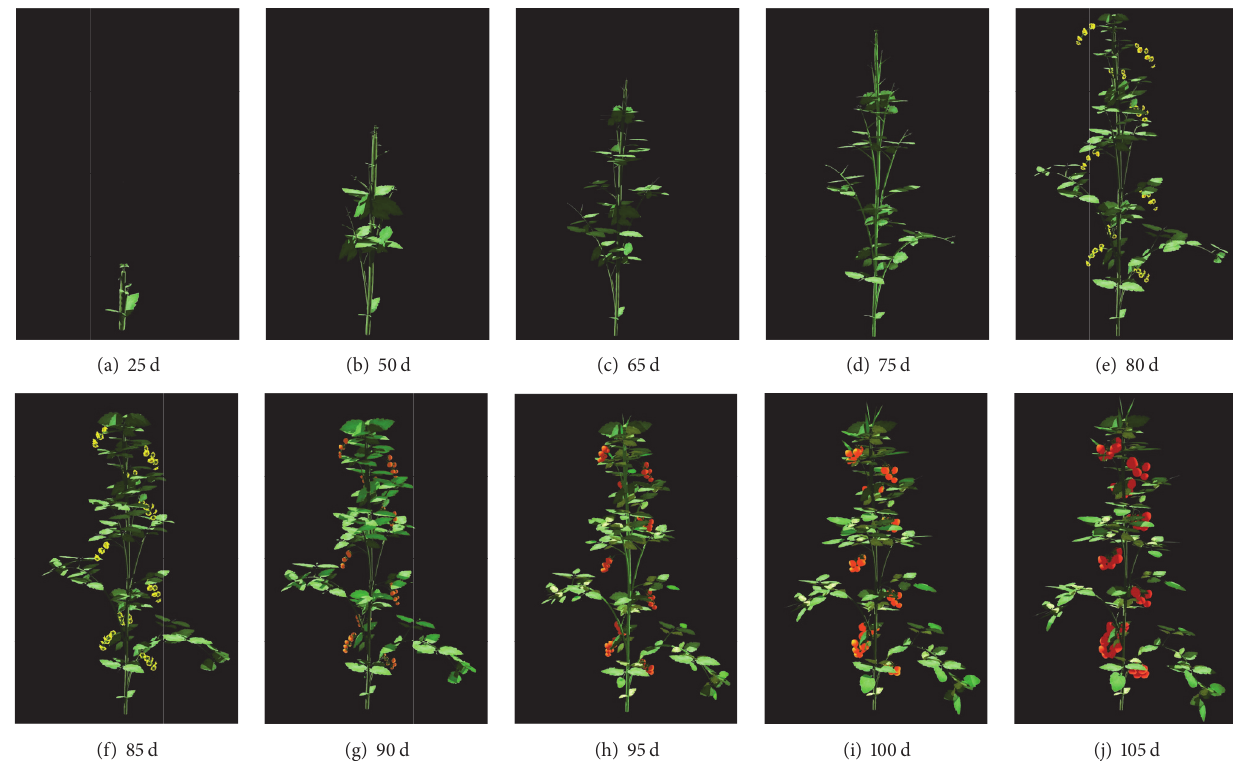
Figure 10: A visual tomato growing series frames generated with our method (in the subfigure title, 𝑖 d means the 𝑖 th day).